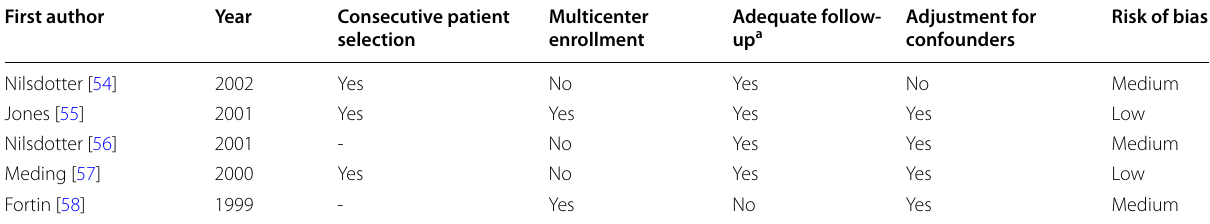
Table 2 Associations of BMI with pain/opioid use after THA